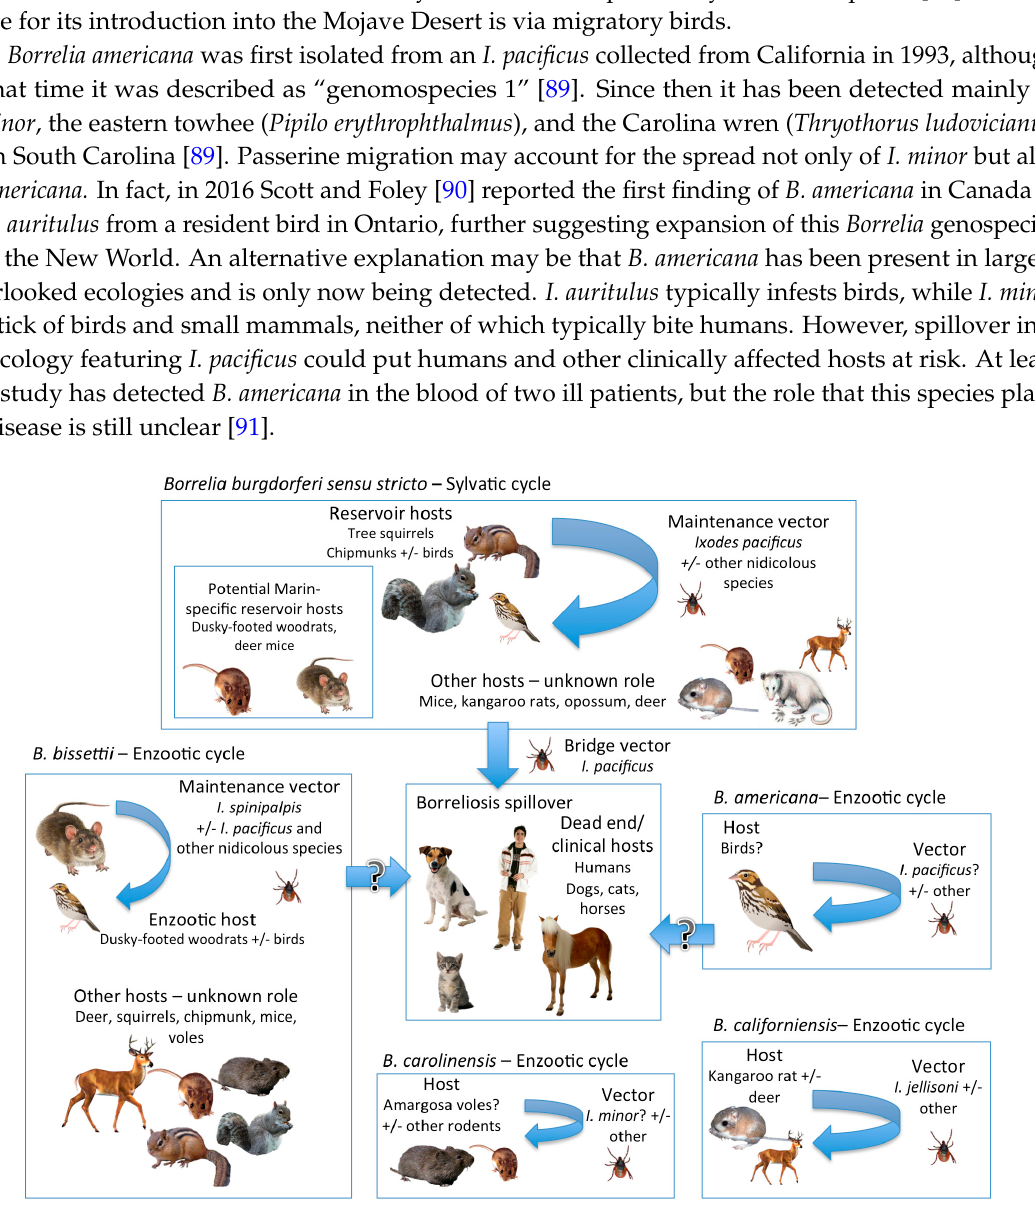
Figure 2. Proposed epidemiological cycles of the Borrelia burgdorferi sensu lato complex in California. As of 2016, B. californiensis has only been detected in Mendocino County in coastal northern California, where it mainly infects the California kangaroo rat ( Dipodomys californicus ) and its specialist tick I. jellisoni [89]. It was also detected in two black-tailed deer, an I. pacificus and I. spinipalpis that were attached to kangaroo rats, and a flagged I. pacificus [15,43,48]. B. californiensis has not been associated with human cases of Lyme disease [15]. Unlike most genospecies of Bbsl, B. bissettii has characteristics similar to Bbss in that it has a broader vertebrate host range, utilizes generalist vectors in the I. ricinus complex, and is found on multiple continents (both North America and Europe). B. bissettii has been implicated in several cases of Lyme disease in eastern Europe with B. bissettii DNA detected in human patients with symptoms typical of Lyme disease including erythematous rash, fatigue, joint pain, and both cardiac and neurologic abnormalities [92–94] and in the cerebrospinal fluid of a German patient with no history of travel [95]. In California, B. bissettii has been detected in the sera of residents of Mendocino County, an area with high prevalence of Bbss, but was not associated with clinical illness [96]. Borrelia bissettii circulates within at least two restricted, local enzootic host-vector cycles [15]. Although the B. bissettii type strain DN127 was first isolated from an I. pacificus , subsequent research showed that it was maintained enzootically in nidicolous I. spinipalpis and woodrats in California and Colorado [43]. This same tick-host couplet maintains the Apsl strain DU1 in California and an un-genotyped A. phagocytophilum strain in an area of Colorado where neither I. pacificus nor I. scapularis bridge vectors are present [97]. As for Bbss, B. bissettii was isolated from several bird species as well as the juvenile stages of I. pacificus that were attached to birds [41]. However, the prevalence of B. bissettii in ticks from birds was much lower than Bbss, and the role of birds as a possible reservoir for B. bissettii is not resolved. B. bissettii has most commonly been detected in the tick I. pacificus , though this may be due to biased sampling as I. pacificus is the most commonly flagged Ixodes sp. tick in California. B. bissettii has also been detected several times in I. spinipalpis that were collected both by flagging and attached to vertebrate hosts as well as once each from an I.